Question: Express in one sentence what the figure is showing.
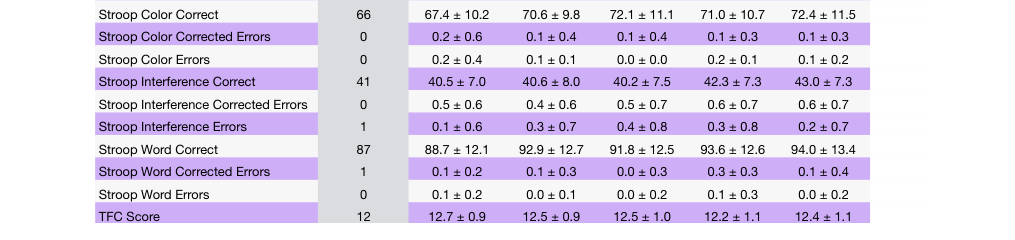
Answer: An example twin record for a single HD patient is shown, which reports the mean and standard deviation of the twins for that patient. A sample of static baseline information is given at the top of the record. A sample of longitudinal outcomes predicted by the model are supplied as rows, with columns indicating the time in months since baseline visit. The number of longitudinal records have been truncated.